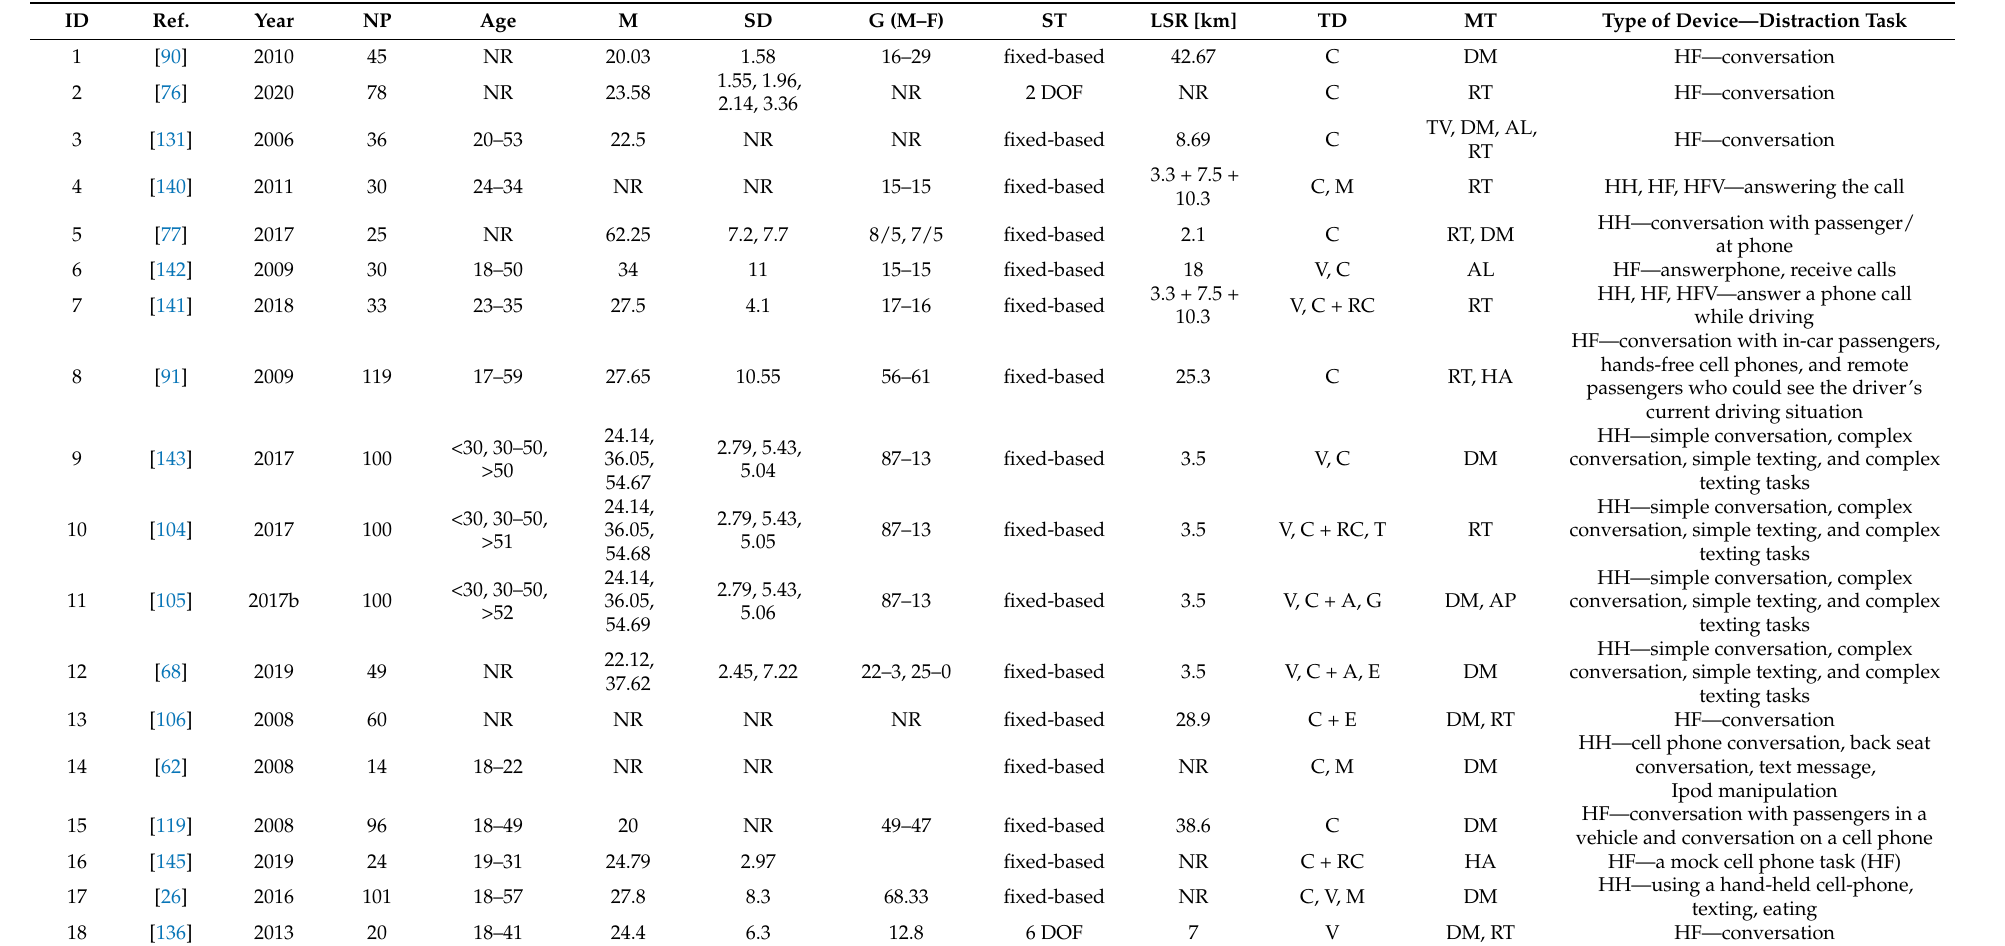
Table A1. Summary of selected